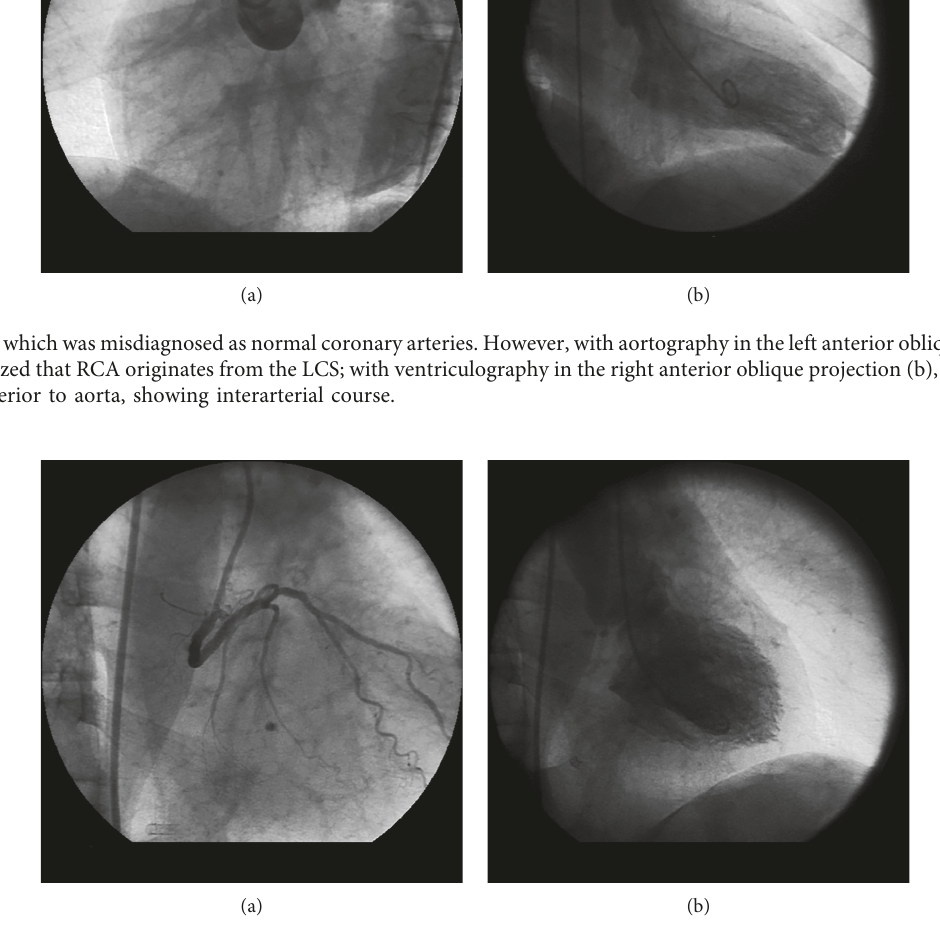
Figure 2: Right coronary sinus injection in the right anterior oblique view: anomalous left circumflex coronary artery is visualized to arise from the right coronary sinus and courses posterior to the aorta (a). Ventriculography in the right anterior oblique view shows a mark posterior to the aorta confirming retroaortic course